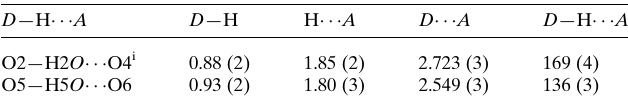
Table 1 Hydrogen-bond geometry (A˚ , (cid:4) ).